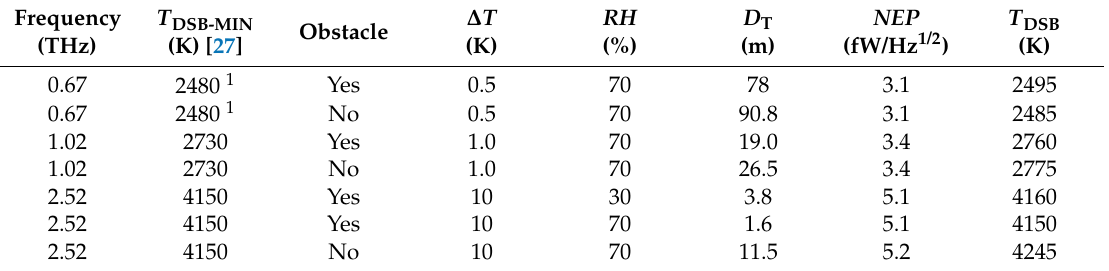
Table 5. Standoff detection scenarios (with and without obstacle) designed to accommodate